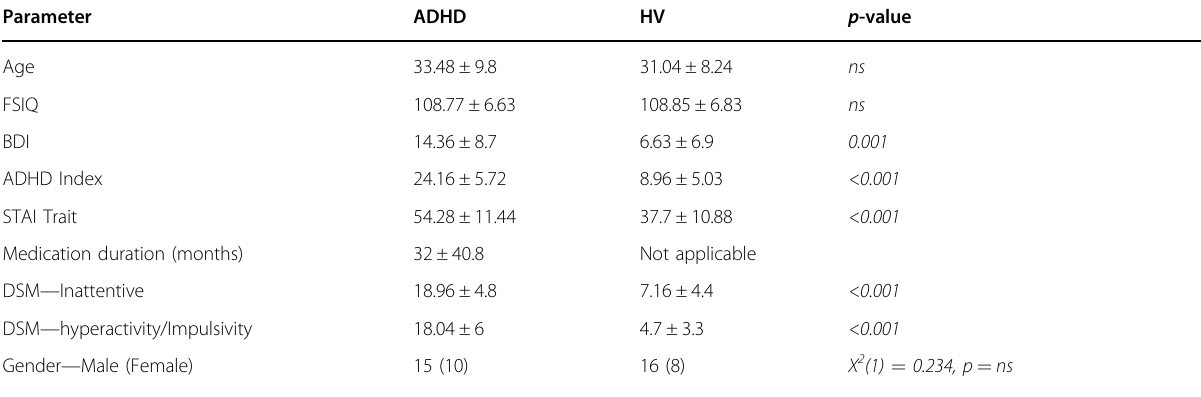
Table 2 Lists the (mean ± standard deviation) of the demographics, clinical measures, behavioural measures and the reinforcement learning estimates between attention-de fi cit hyperactivity disorder group and Healthy